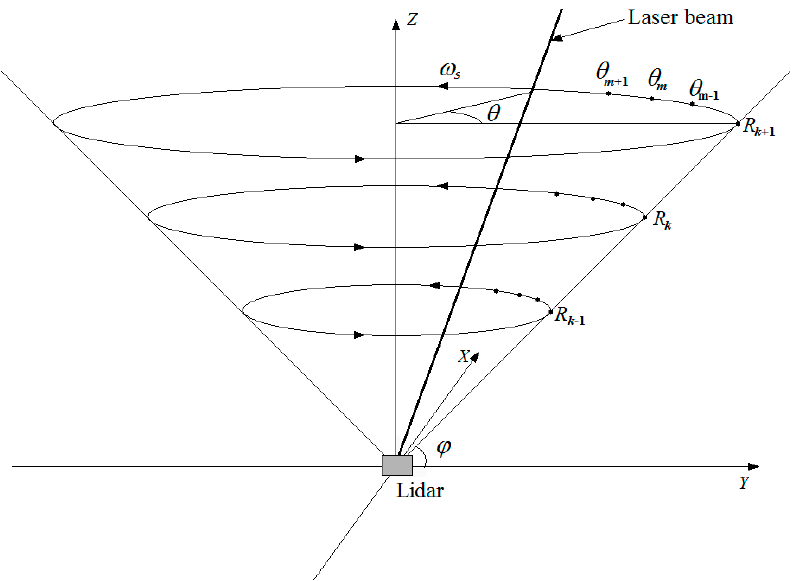
Figure 2. Geometry of the conical scanning by the lidar probing beam.